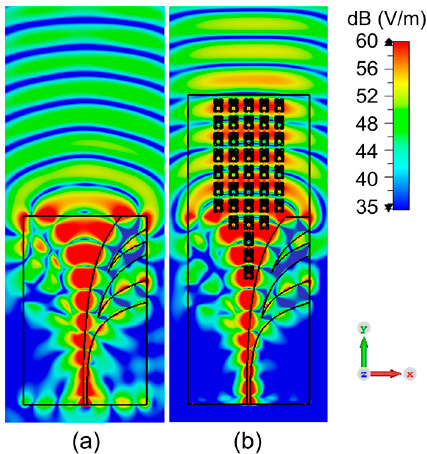
Figure 9. Full-wave simulation of the AVA with di ff erent L-shaped metalenses: ( a ) modulus of the sca tt ering parameter |S 11 | as a function of frequency, and ( b ) realized gain G and gain increase Δ𝐺 as a function of frequency.